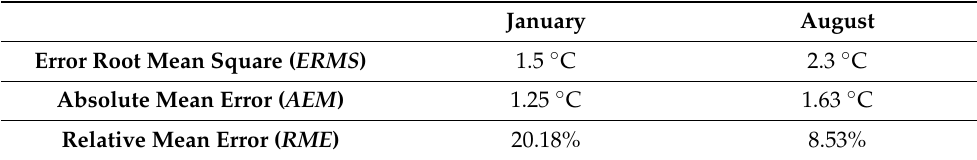
Figure 41. Simulated (blue) and measured (orange) ambient temperature for August. Table 21. Error between simulated and measured